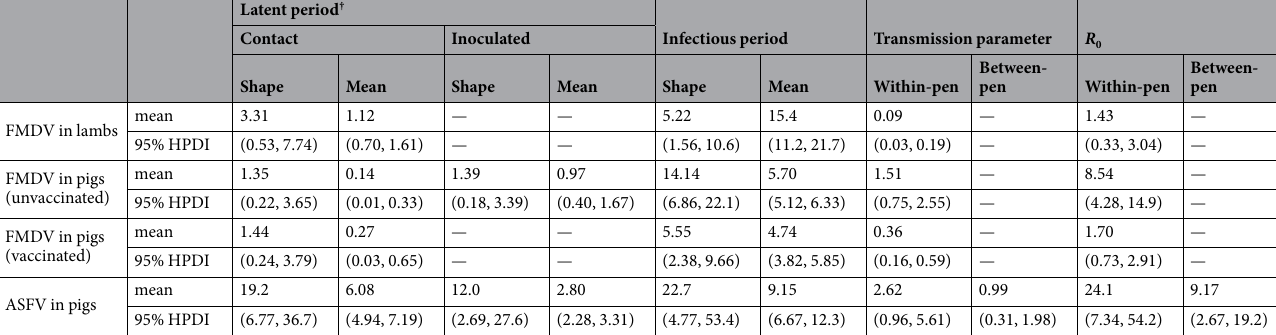
a long time, but at a low rate of transmission. The resulting estimate (posterior mean) for R 0 is 1.43, with the 95% HPDI including the threshold value of R 0 = 1. The inferred infection times for the three (out of 12) contact lambs which became infected are shown in Fig. 3. The two lambs (9893 and 9769) are from the same group (group D) and the infection times suggest that one con- tact lamb (9769) could have acted as the source of infection for the other (9893).